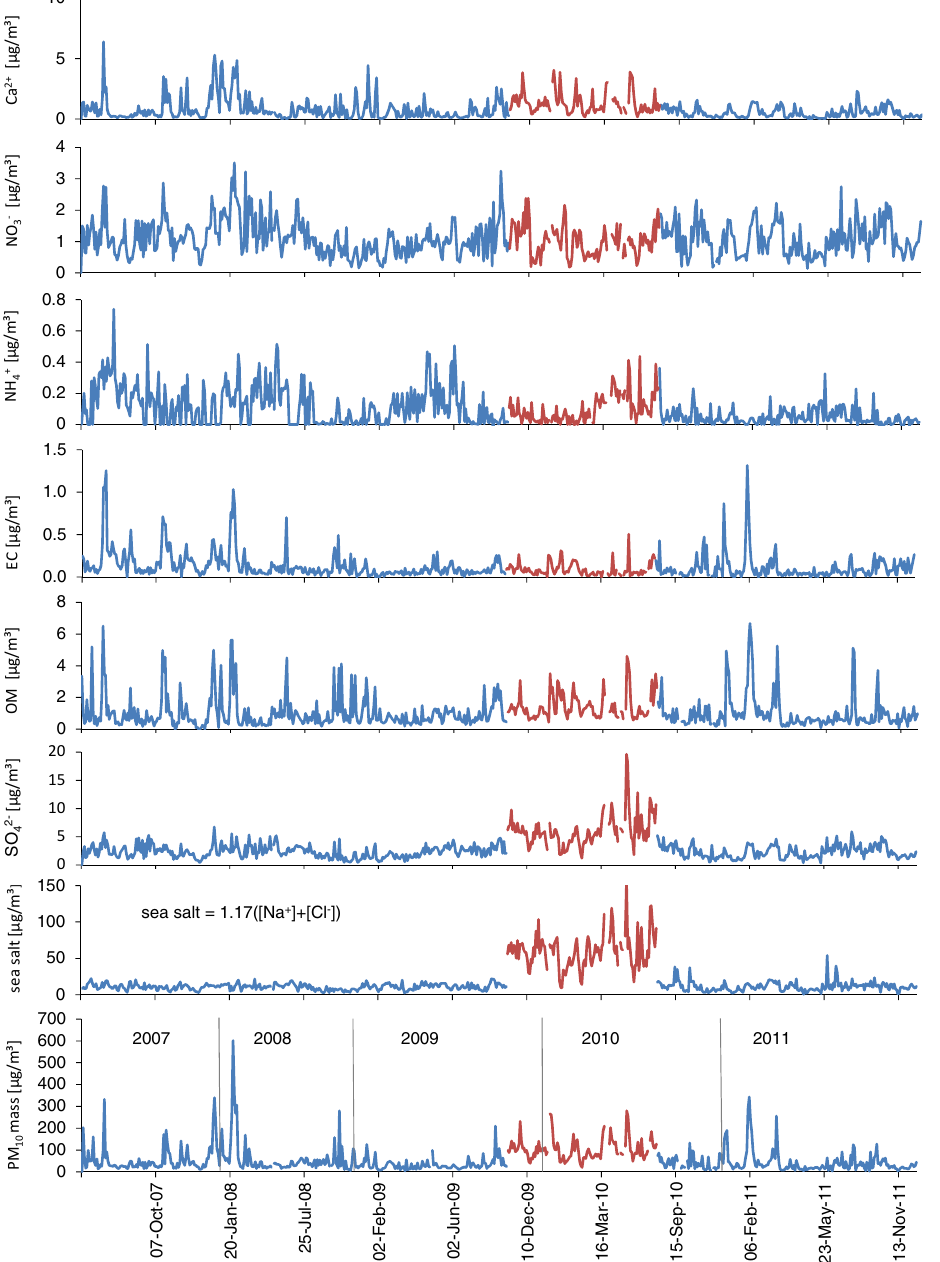
Figure 3. Time series of mass concentration and major PM 10 aerosol components in filter samples collected during the 5 years from 2007 to 2011. During the period from 23 October 2009 till 09 July 2010 (red line) all samples were collected on top of a storage container with an inlet height of 4m above ground; all other samples were collected on top of the tower with an inlet height of 32m above